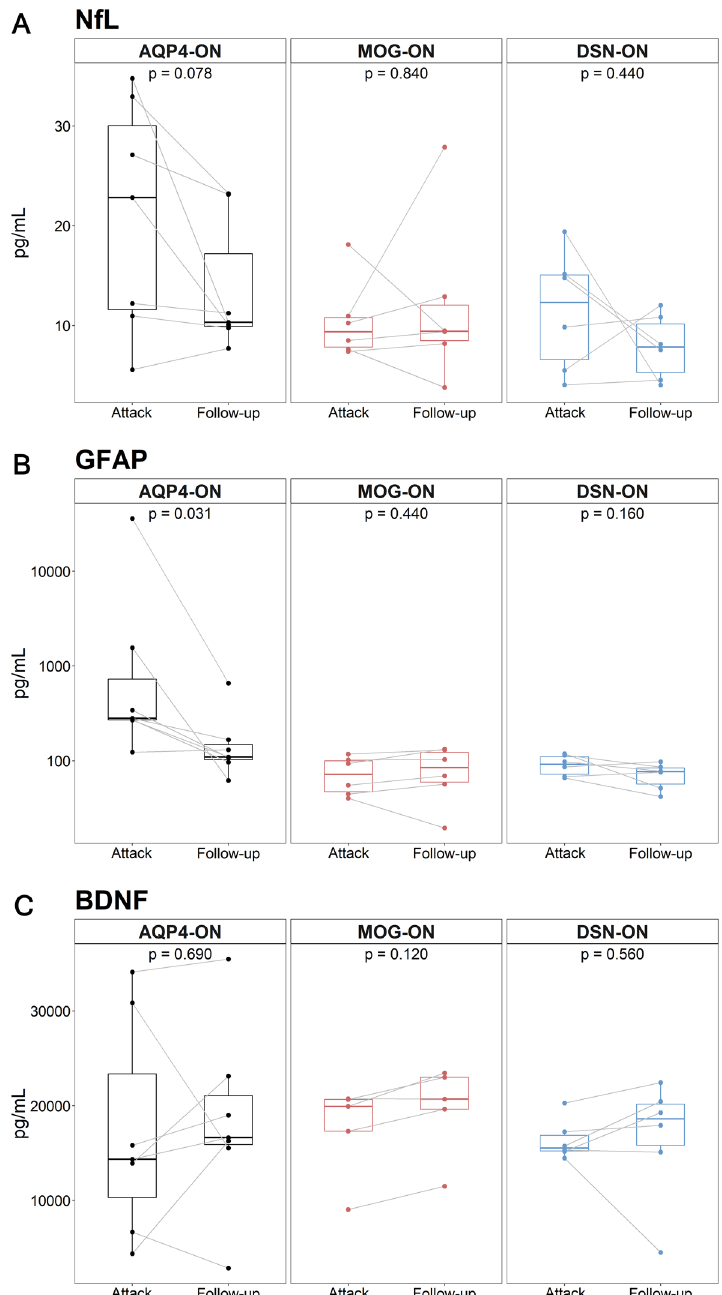
Figure 3. Longitudinal serum biomarker analysis in patients with AQP4-ON, MOG-ON, and DSN-ON. In longitudinal analyses, serum ( A ) NfL, ( B ) GFAP, and ( C ) BDNF levels were compared between baseline (attack state) and follow-up (remission state) in consecutive patients. AQP4-ON optic neuritis with aquaporin-4 antibody, BNDF brain-derived natriuretic factor, DSN-ON double-seronegative optic neuritis, GFAP glial fibrillary acidic protein, MOG-ON optic neuritis with myelin oligodendrocyte glycoprotein antibody, NfL neurofilament light